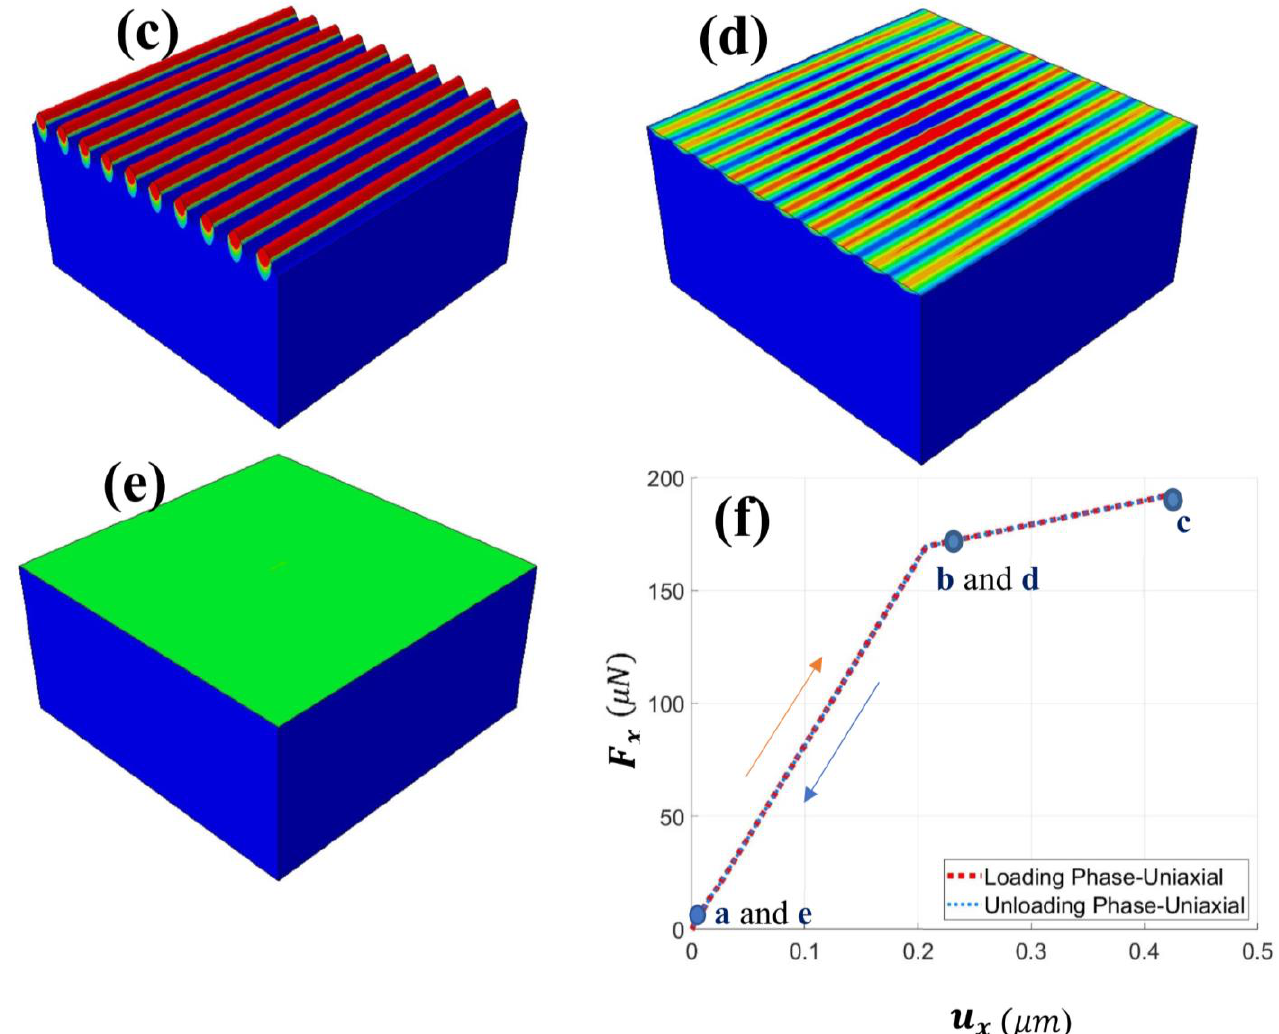
Figure 2. Snapshots of simulated surface patterns during the loading phase (from ( a – c )) and unload- ing phase (from ( c – e )) under uniaxial compression. ( f ) Overall load–displacement response for the entire deformation history, with the five stages ( a – e ) labeled along the curves.